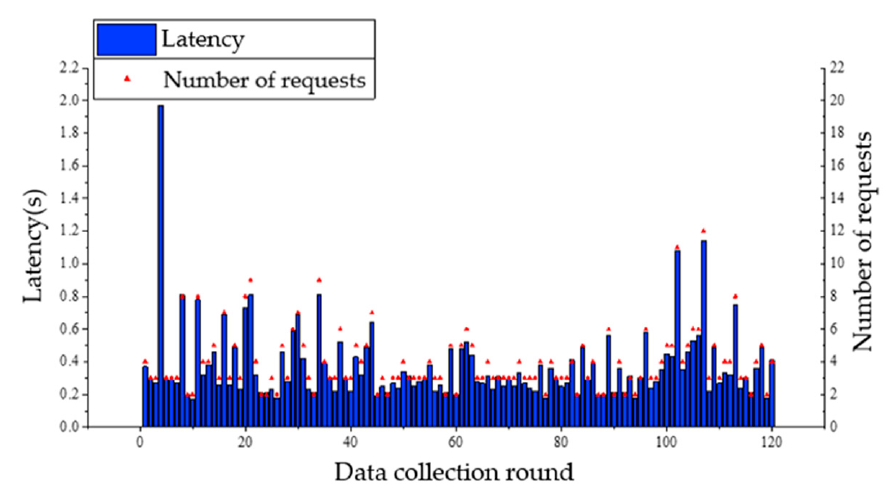
Figure 15. Communication latency of node A and the number of requests from UAV when flight altitude is 5 m.